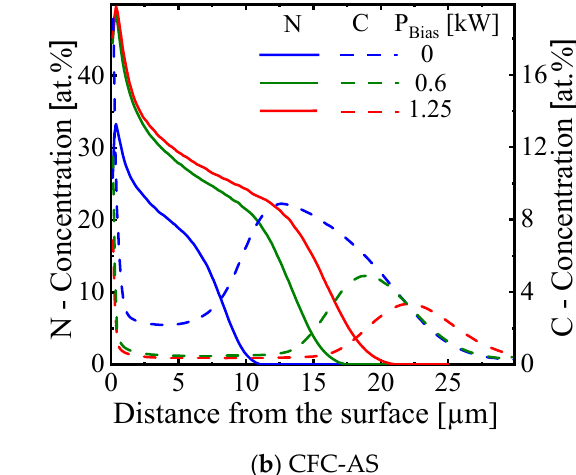
( b ) CFC-AS Figure 12. Top-view SEM images of samples after ASPNC treatment for a steel AS ( Φ CH4 = 4 slh) ( a ) and a CFC-AS ( b ) at H 2 :N 2 = 1:1, p = 3 mbar, T = 460 °C, Φ Total = 80 slh, P Bias = 1.25 kW, and t = 5 h. Figure 13 shows the X-ray diffraction patterns of AISI 316L treated using a steel AS and a CFC-AS with different biased conditions, as well as the untreated reference sample. For the untreated AISI 316L, two characteristic peaks were observed at angles of 51.1° and 59.7°, corresponding to the fcc γ (111) and γ (200) peaks of AISI 316L austenitic stainless steel, respectively. In the case of the ASPNC samples treated with biased conditions using both steel AS and CFC-AS, two defined peaks of the metastable nitrogen-expanded austenite appeared, indicated as γ N (111) and γ N (200), which were shifted to the lower angels and broader compared to the peaks of the untreated sample, respectively. In addition, it was revealed for both AS materials that the peak positions of γ N (111) and γ N (200) changed for the treatment with different bias conditions. For the sample treated